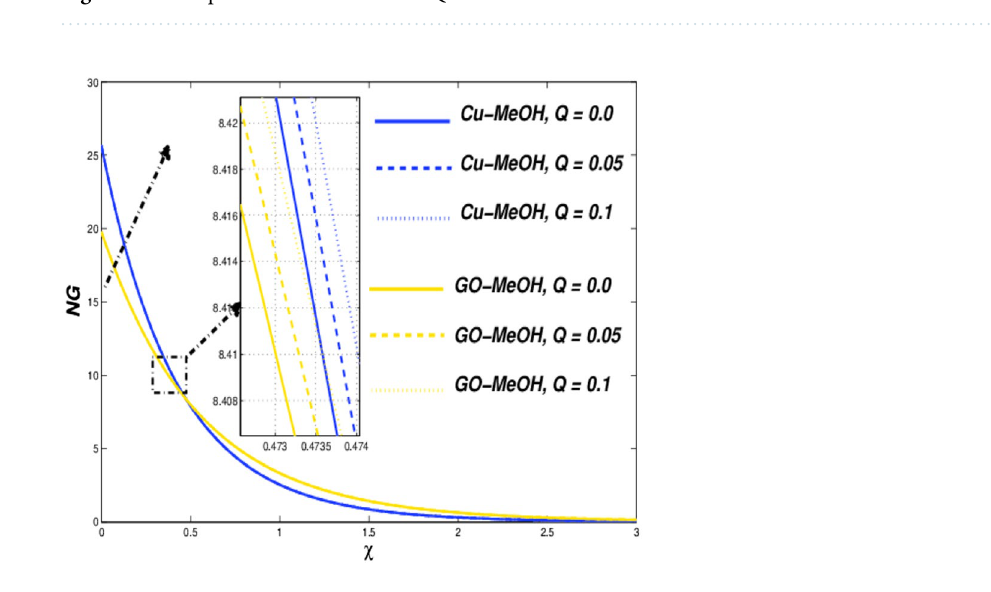
Figure 23. Entropy variation versus Q